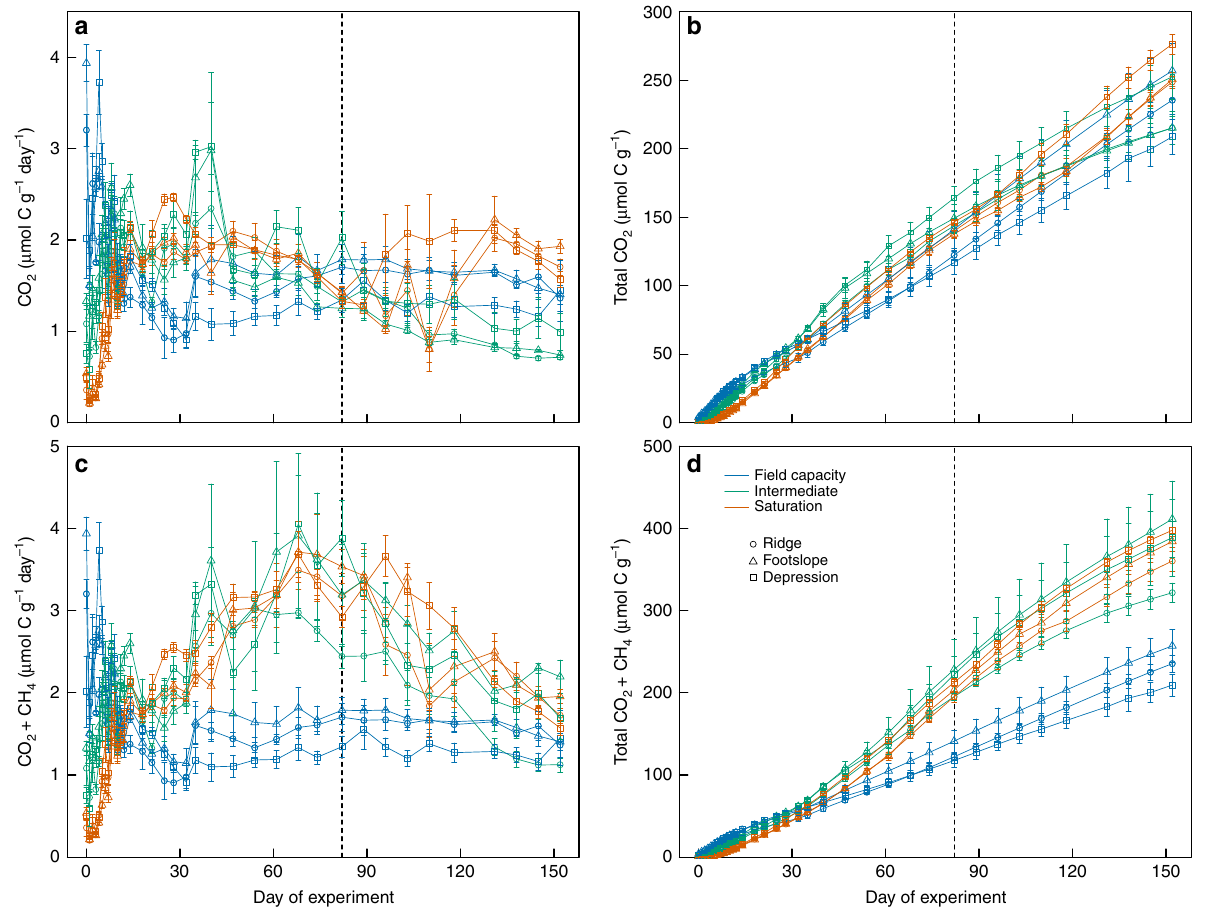
Fig. 1 Carbon mineralization from three Mollisols incubated under moisture levels at and above fi eld capacity. a CO 2 production rate; b cumulative CO 2 production; c total C mineralization rate (CO 2 + CH 4 ); d cumulative total C mineralization (CO 2 + CH 4 ). The vertical dashed line indicates when gradual drainage was initiated in the saturated soils. The error bars indicate s.e.m. ( n =